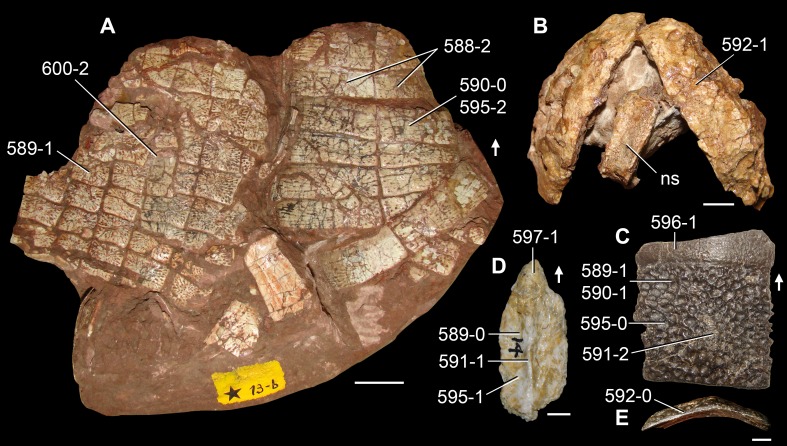
Dermal armour of Triassic archosauriforms in (A, C, D) external and (B, E) posterior views.(A) Partial ventral (left) and dorsal (right) armours of Aetosauroides scagliai (MCP 13a-b-PV); (B) pair of paramedian dorsal osteoderms in subarticulation with the distal end of a neural spine of Archeopelta arborensis (CPEZ-239a); (C, E) dorsal osteoderm of Doswellia kaltenbachi (USNM 244214); and (D) paramedian dorsal osteoderm of Euparkeria capensis (UMCZ T692). Numbers indicate character-states scored in the data matrix and the arrows indicate anterior direction. Scale bars equal 2 cm in (A), 5 mm in (B, C, E), and 2 mm in (D).